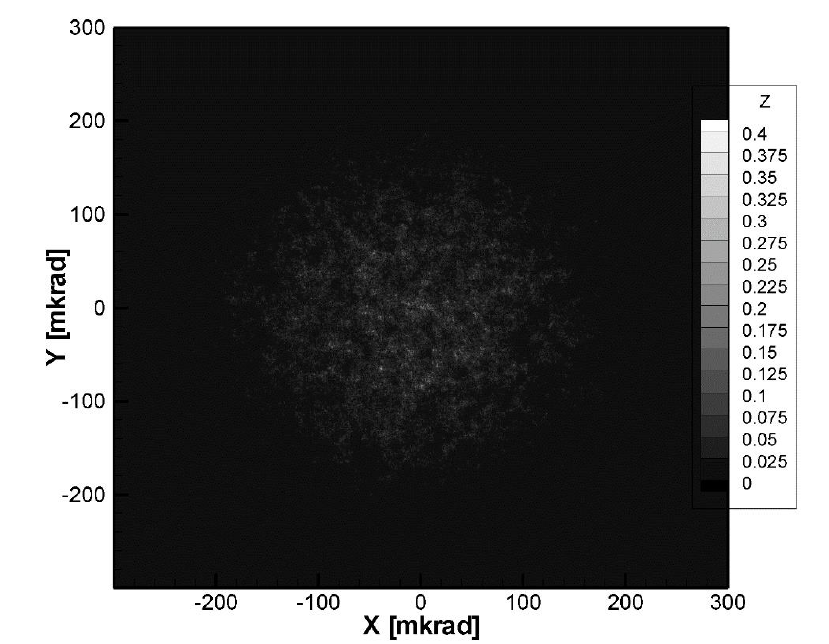
Fig. 2. The distribution of the amplitude in the beam cross section is divergent 3 2 0.3 10    at a distance of 16 km from the